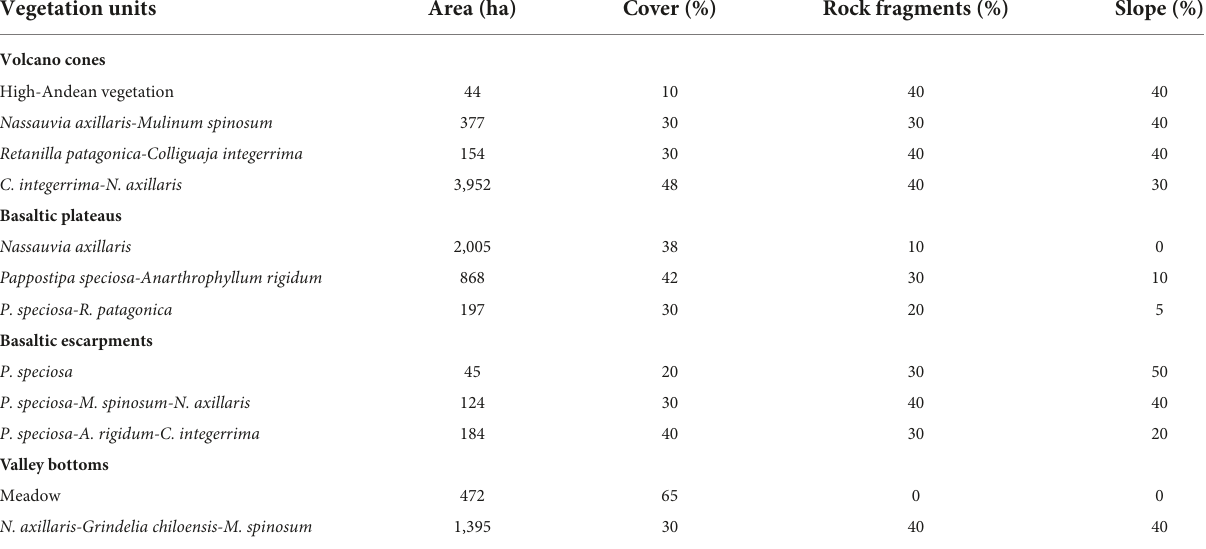
TABLE 3 Area (ha), vegetation cover (%), rock fragments (%), slope (%) of the vegetation units. Vegetation units Area (ha) Cover (%) Rock fragments (%) Slope (%)